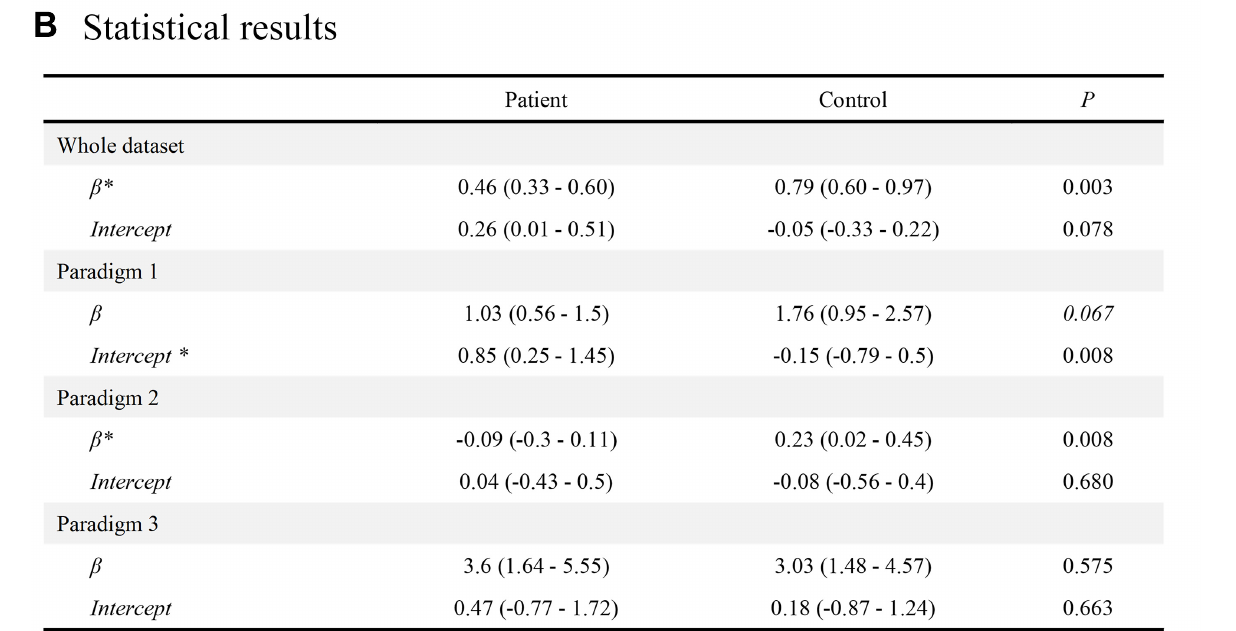
FIGURE 4 | The results of the duration task. (A) The results from the patient group (red line) are presented above the regression results from the age-matched control group (blue line). (B) The results of statistical analyses for the duration task. Statistical analyses were performed using the generalized linear model with logit fit. For clarity, the statistical model presented in this figure did not include velocity covariates. An asterisk ( ∗ ) indicates the parameters with statistical significance. The level of statistical significance was set at 0.05 for the whole dataset and 0.0167 for the paradigms 1–3. IpL, ipsilesional; CoL, contralesional; PSE, point of subjective equality, which is the stimulus amplitude that corresponds to the 0.5 probability